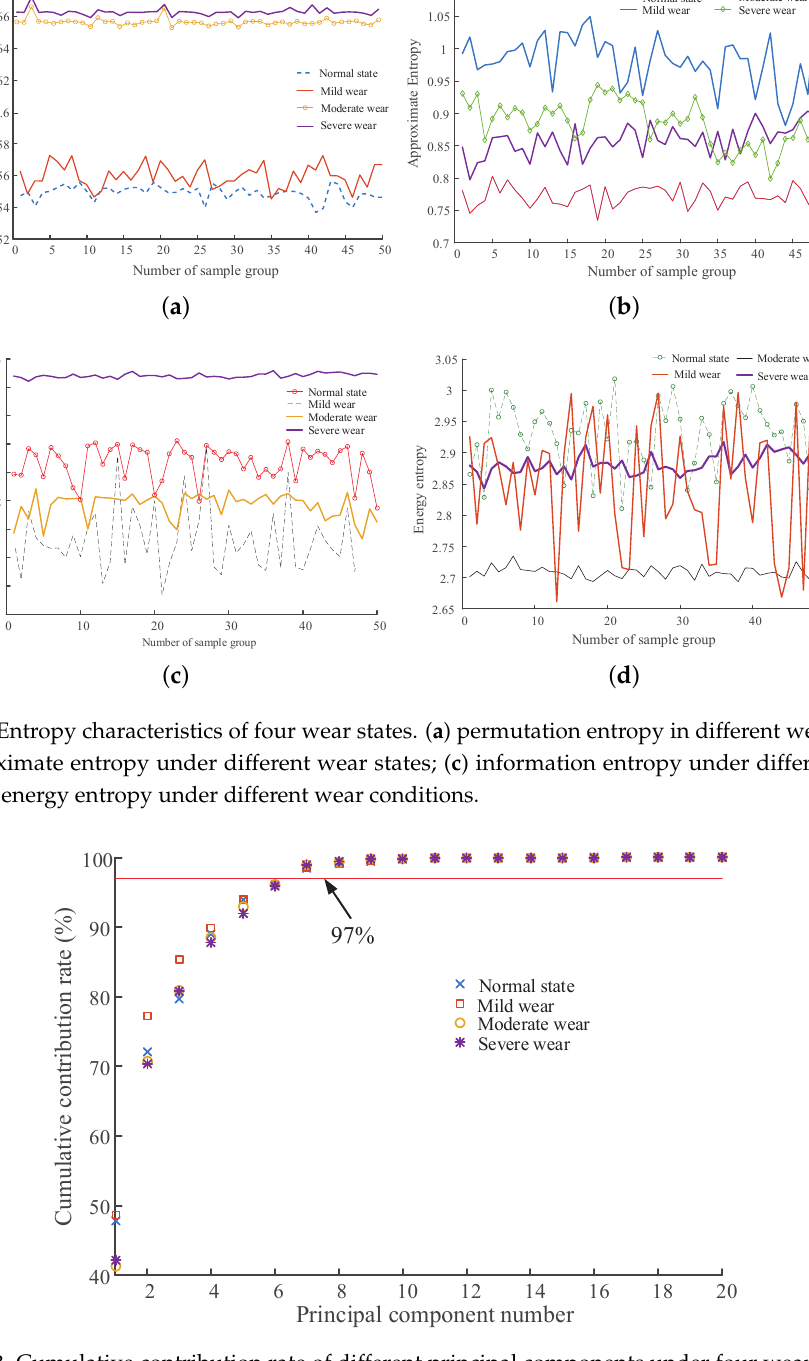
Figure 8. Cumulative contribution rate of different principal components under four wear